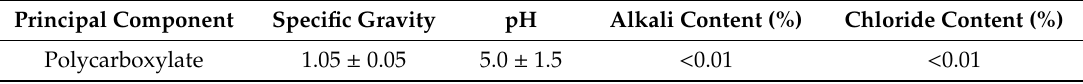
Table 3. Characteristics of the used high-performance water reducing agent.